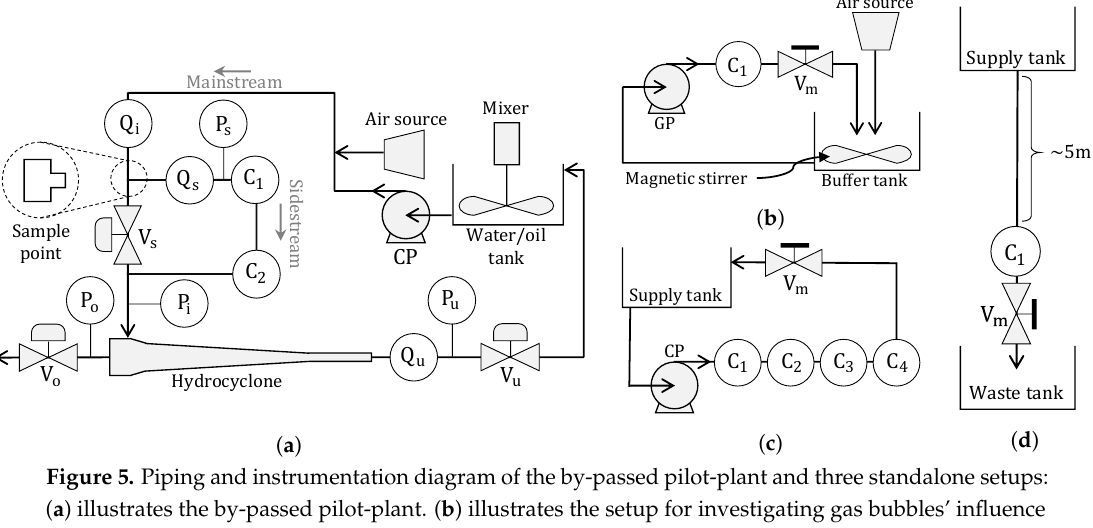
Figure 5. Piping and instrumentation diagram of the by-passed pilot-plant and three standalone setups: ( a ) illustrates the by-passed pilot-plant. ( b ) illustrates the setup for investigating gas bubbles’ influence on a OiW monitor. ( c ) illustrates the setup for comparison of the four OiW monitors’ calibration. ( d ) illustrates a gravitation feed setup to isolate internal